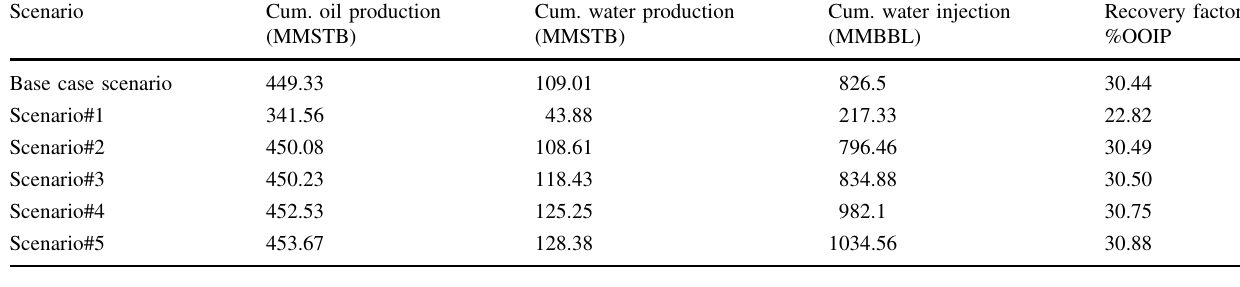
Table 1 Production statistics at the end of prediction period (2026) for scenarios 1–5 Scenario